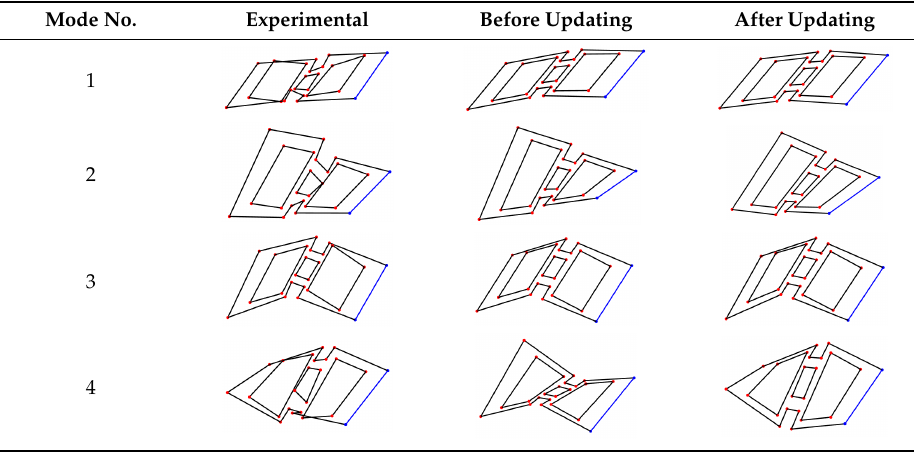
Table 9. Comparison of Modal Shapes Before and After Model Updating.